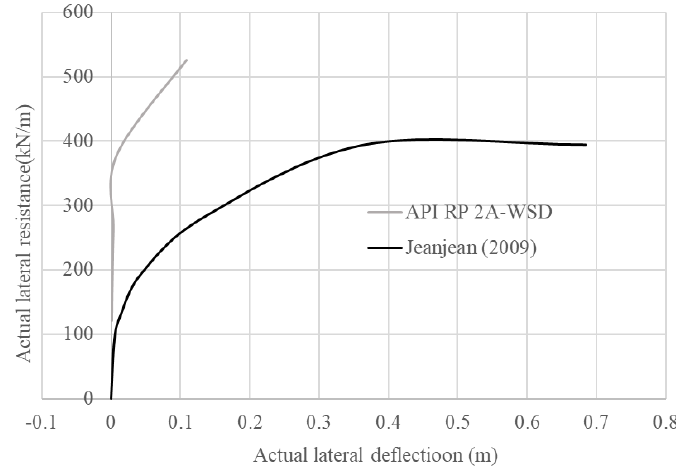
Figure 7. Model of a single pile with single stratum soil layer.